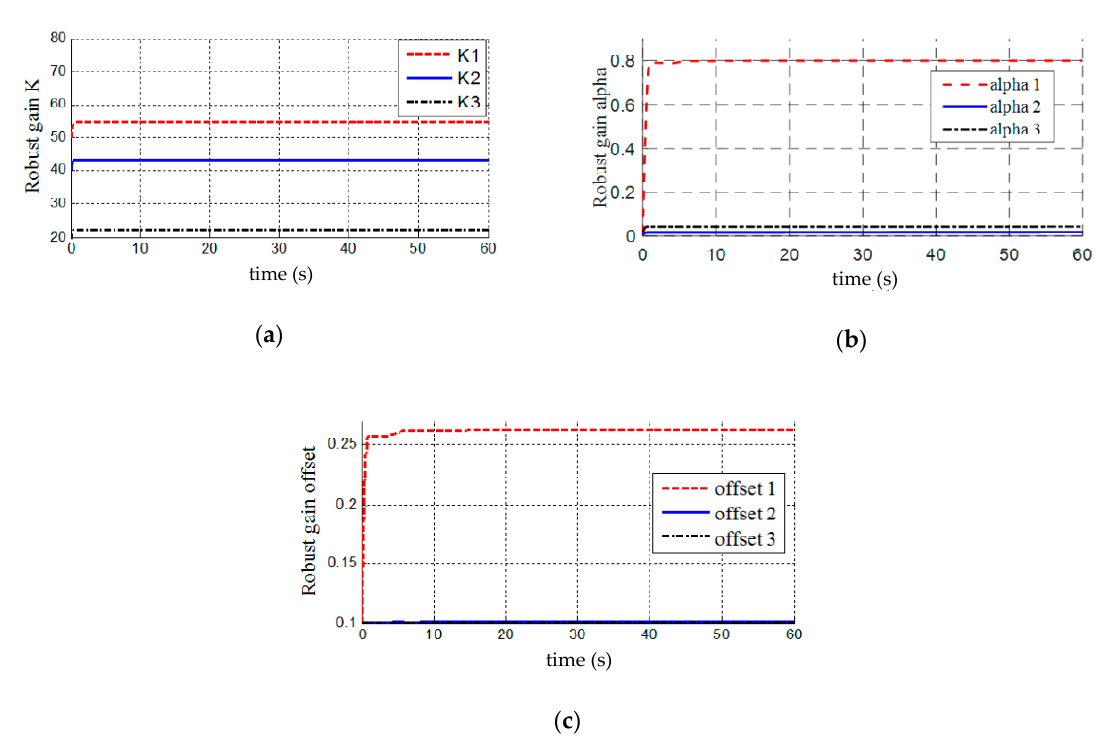
Figure 14. The adaptive gains: ( a ) Robust gain K, ( b ) α , ( c ) offset gains of the i th joint, where i = 1,2,3 with respect to the first joint, the second joint, and the third joint.